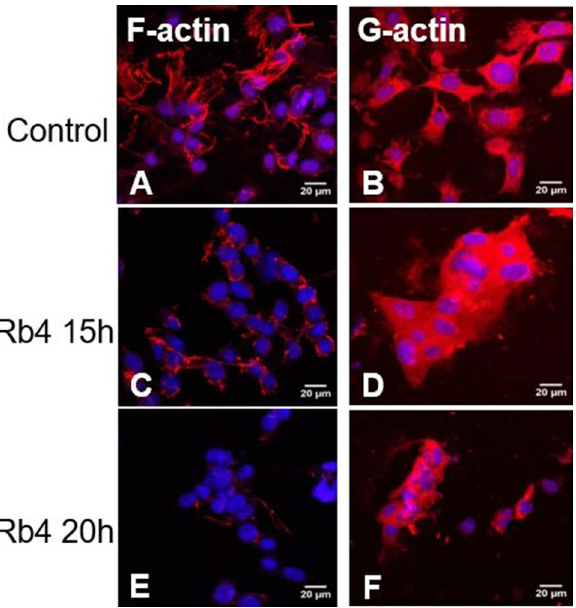
Figure 8. Rb4 affects actin polymerization and depolymerization. B16F10-Nex2 cells were treated with 0.15 mM Rb4 for 15 h or 20 h. After incubation, the cells were fixed, permeabilized and incubated with phalloidin-rhodamine and DAPI ( A , C , E ) to stain filamentous actin. Note the close to full loss of F-actin structure in C and E after Rb4 treatment for 15 and 20 h. B16F10-Nex2 cells were also fixed, permeabilized and incubated with Dnase I ( B , D , F ) to stain globular actin. Images are representative fields from coverslips analyzed by confocal microscopy detection.